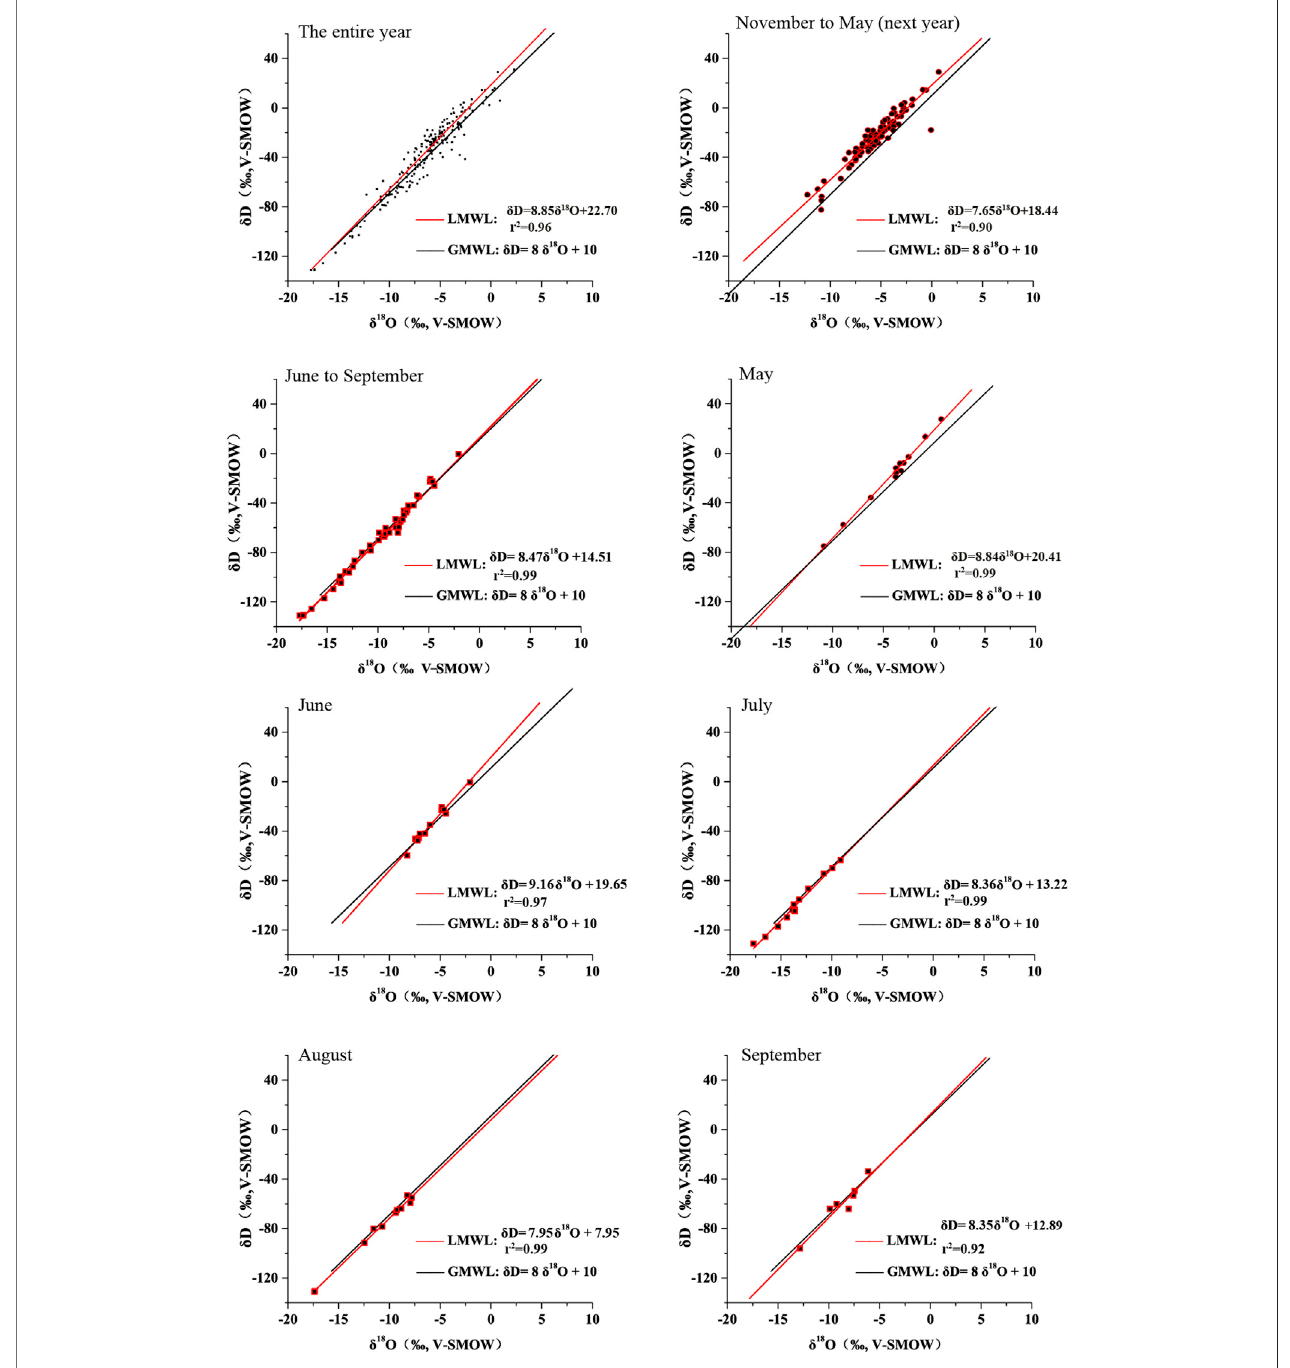
FIGURE3| Linearregressionlinesconformedbythe δ 18 O